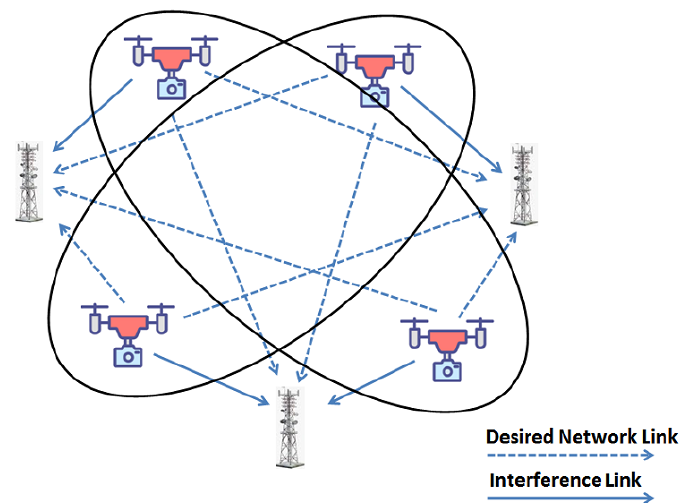
Figure 3. Multi UAV system and varying links’ quality demands.